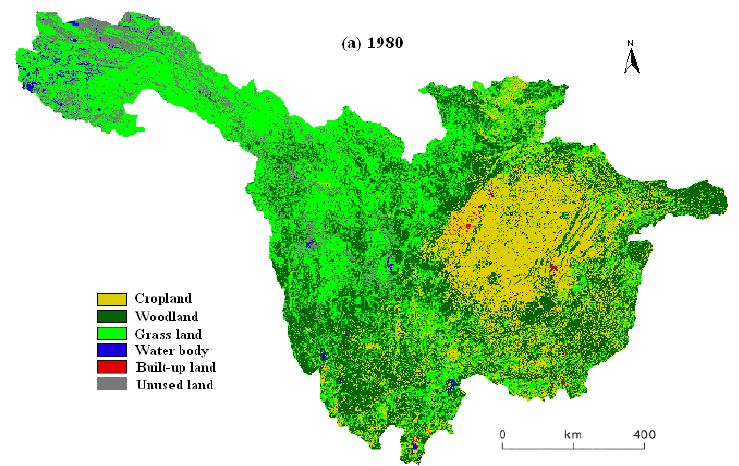
Figure 2. Land use in the upper reaches of the Yangtze River in 1980 (top), 1990 (middle) and 2000